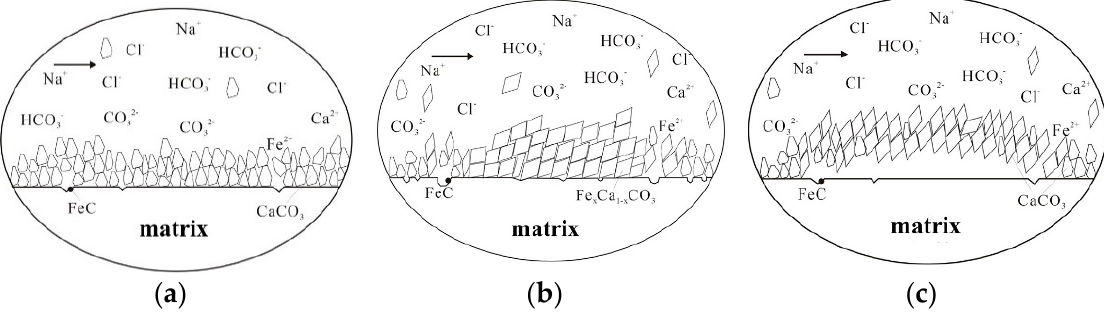
Figure 10. Corrosion process in the fluid environment. ( a ) the precipitation of CaCO 3 ; ( b ) the formation of Fe x Ca 1 − x CO 3 scale; ( c ) the peeling of Fe x Ca 1 − x CO 3 scale by fluid.